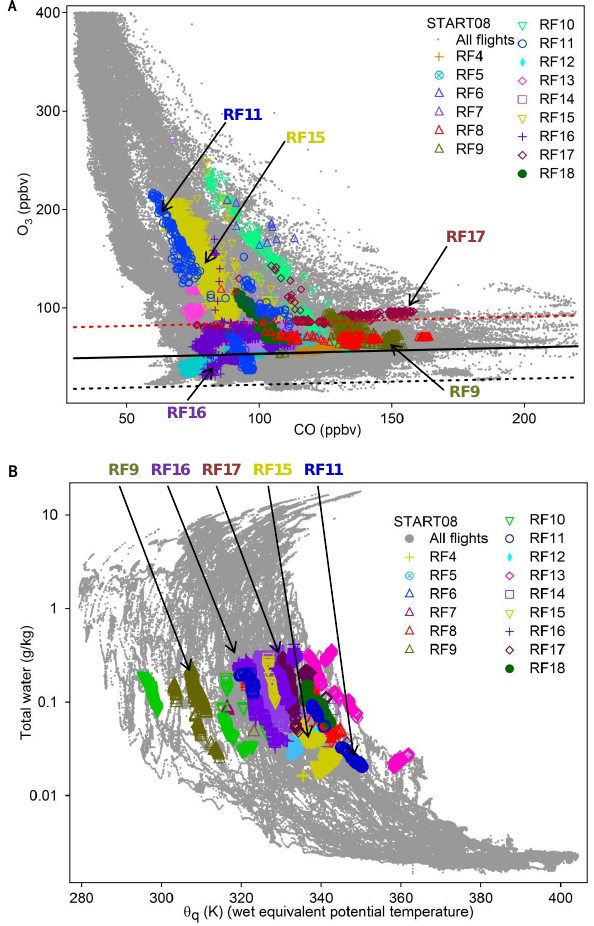
Fig. 12. ISS observations along mixing lines in conservative tracer– tracer correlations. (A) O 3 –CO correlations from START08 cam- paign. (B) Total water content and θ q correlations in START08. The horizontal solid black line is the linear fit to the tropospheric branch of all RHi observations and dotted lines are the ± 3 σ of the fits. For reference, grey background points in (A) and (B) show the observations in all T ranges. We note that part of the high ozone data are not shown in (A) . ISS data are colored by individual flight numbers with the same markers in (A) and (B) . Because the mix- ing lines overlap with each other in (A) and (B) , we highlighted a few straight mixing lines with arrows and colored flight numbers as examples (see arrows with labels in the